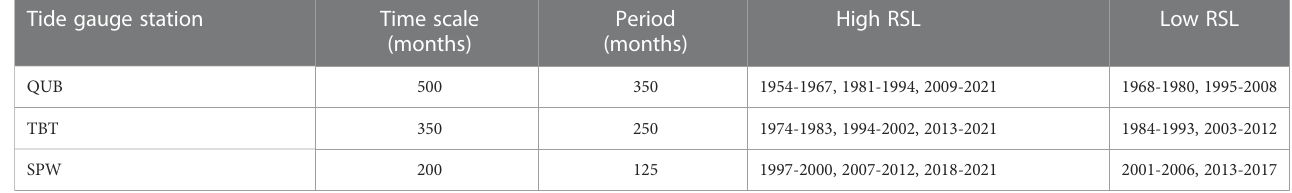
TABLE 1 First major period and the period scale of three tide gauge stations.